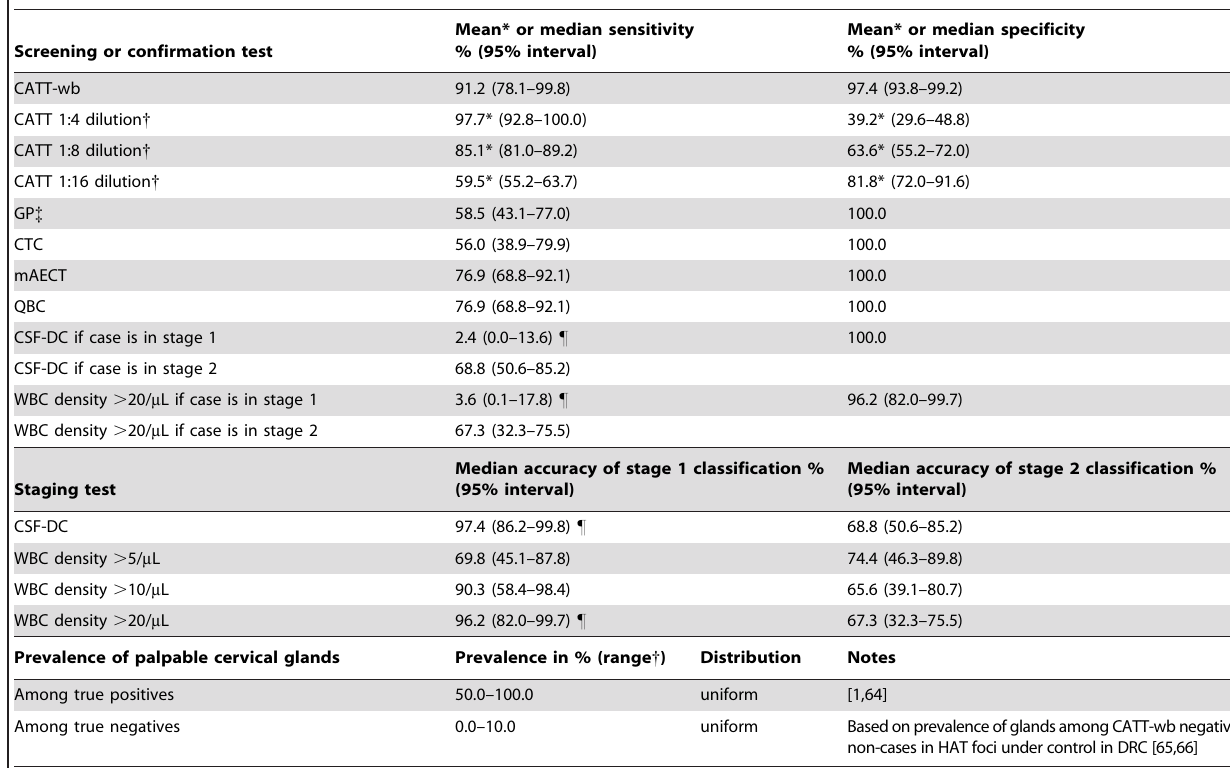
Table 3. Input parameter values for baseline